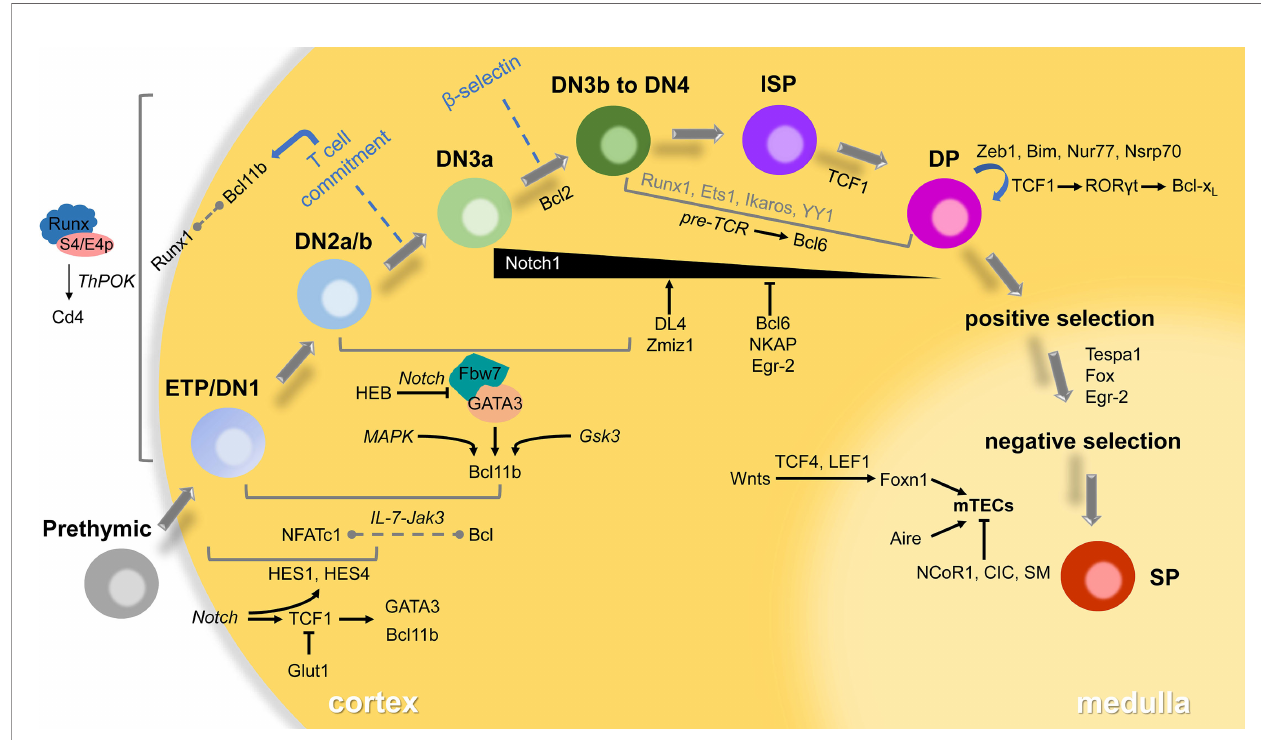
FIGURE 1 | Transcriptional regulators in thymocyte development. T-lymphocytes go through several distinct stages according to expressed TCRs or surface markers in the thymus. The developing cells will pass checkpoints ( b -selection, positive selection and negative selection) to become mature SP thymocytes, then emigrate to the periphery to differentiate to functional subsets. Most of the transcriptional regulators play roles in speci fi c stages via small networks involving signaling in italics. Some interaction between factors remains unclear that displayed in the dotted line. The participants of a few transcriptional factors in grey are also poorly